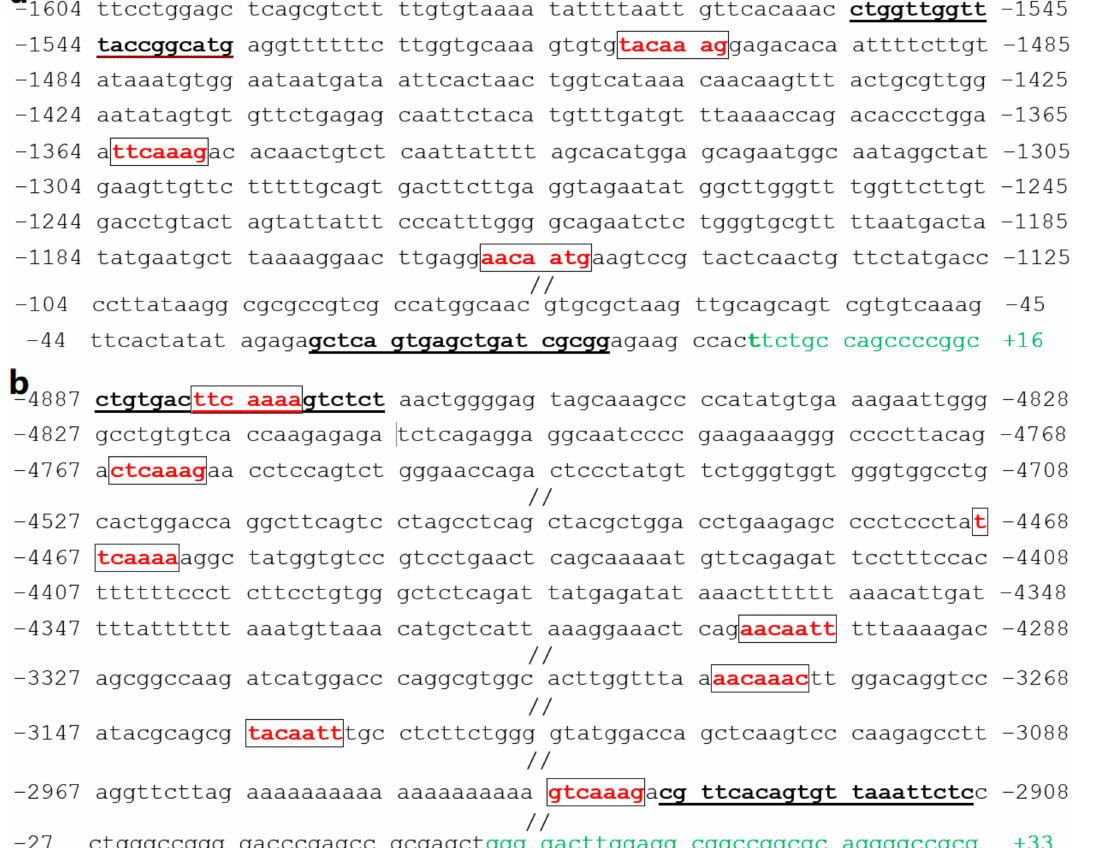
Figure 6. The SOX18-binding sites in the promoters of NR2F2 and GATA4 . ( a ) Multiple SOX18- binding sites mapped in the promoter of NR2F2 . ( b ) Multiple variants of SOX18-binding sites mapped in the promoter of GATA4 . Red color marks the SOX18-binding sites or their variants; green color: the first exon encoding mRNA; underlined bases: primer